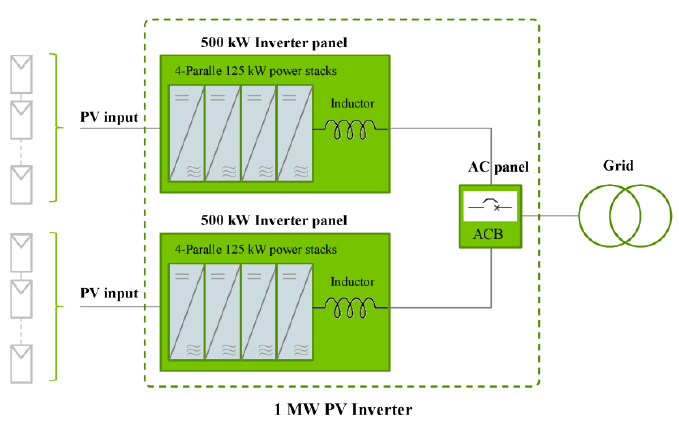
Figure 9. 1 MW PV system used in the experiment.